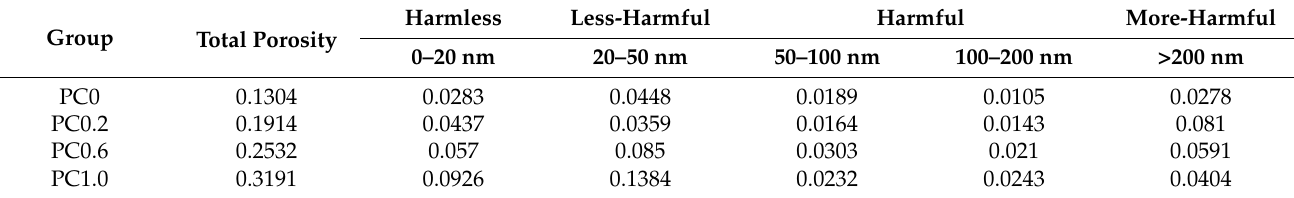
Table 2. The porosity in different pore size intervals of the cement specimens